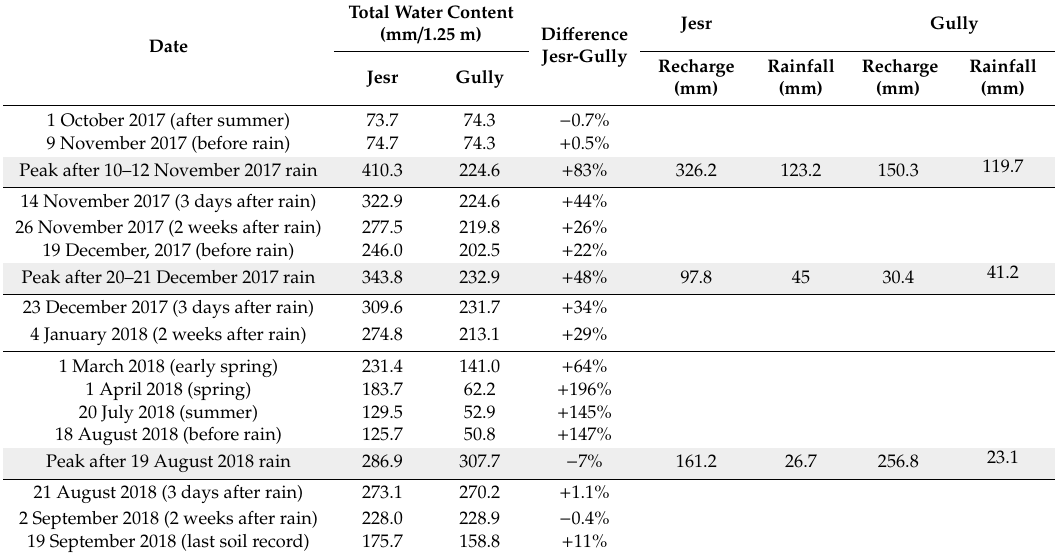
Table 4. Left table: evolution of total water content in the Jesr and gully soil profiles throughout the monitoring period and at two key moments after rainfall events. Right table: recharge in water content corresponding to the peak of water content in the Jesr and in the gully following each rainfall event. The rainfall events are highlighted in grey. Total Water Content (mm / 1.25